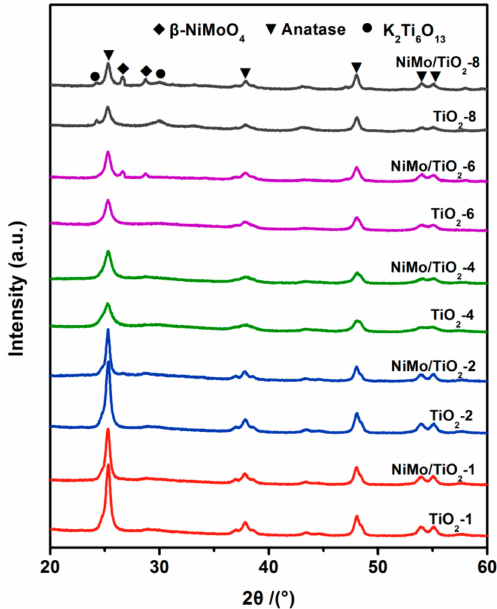
Figure 1. XRD patterns of various catalysts and their corresponding